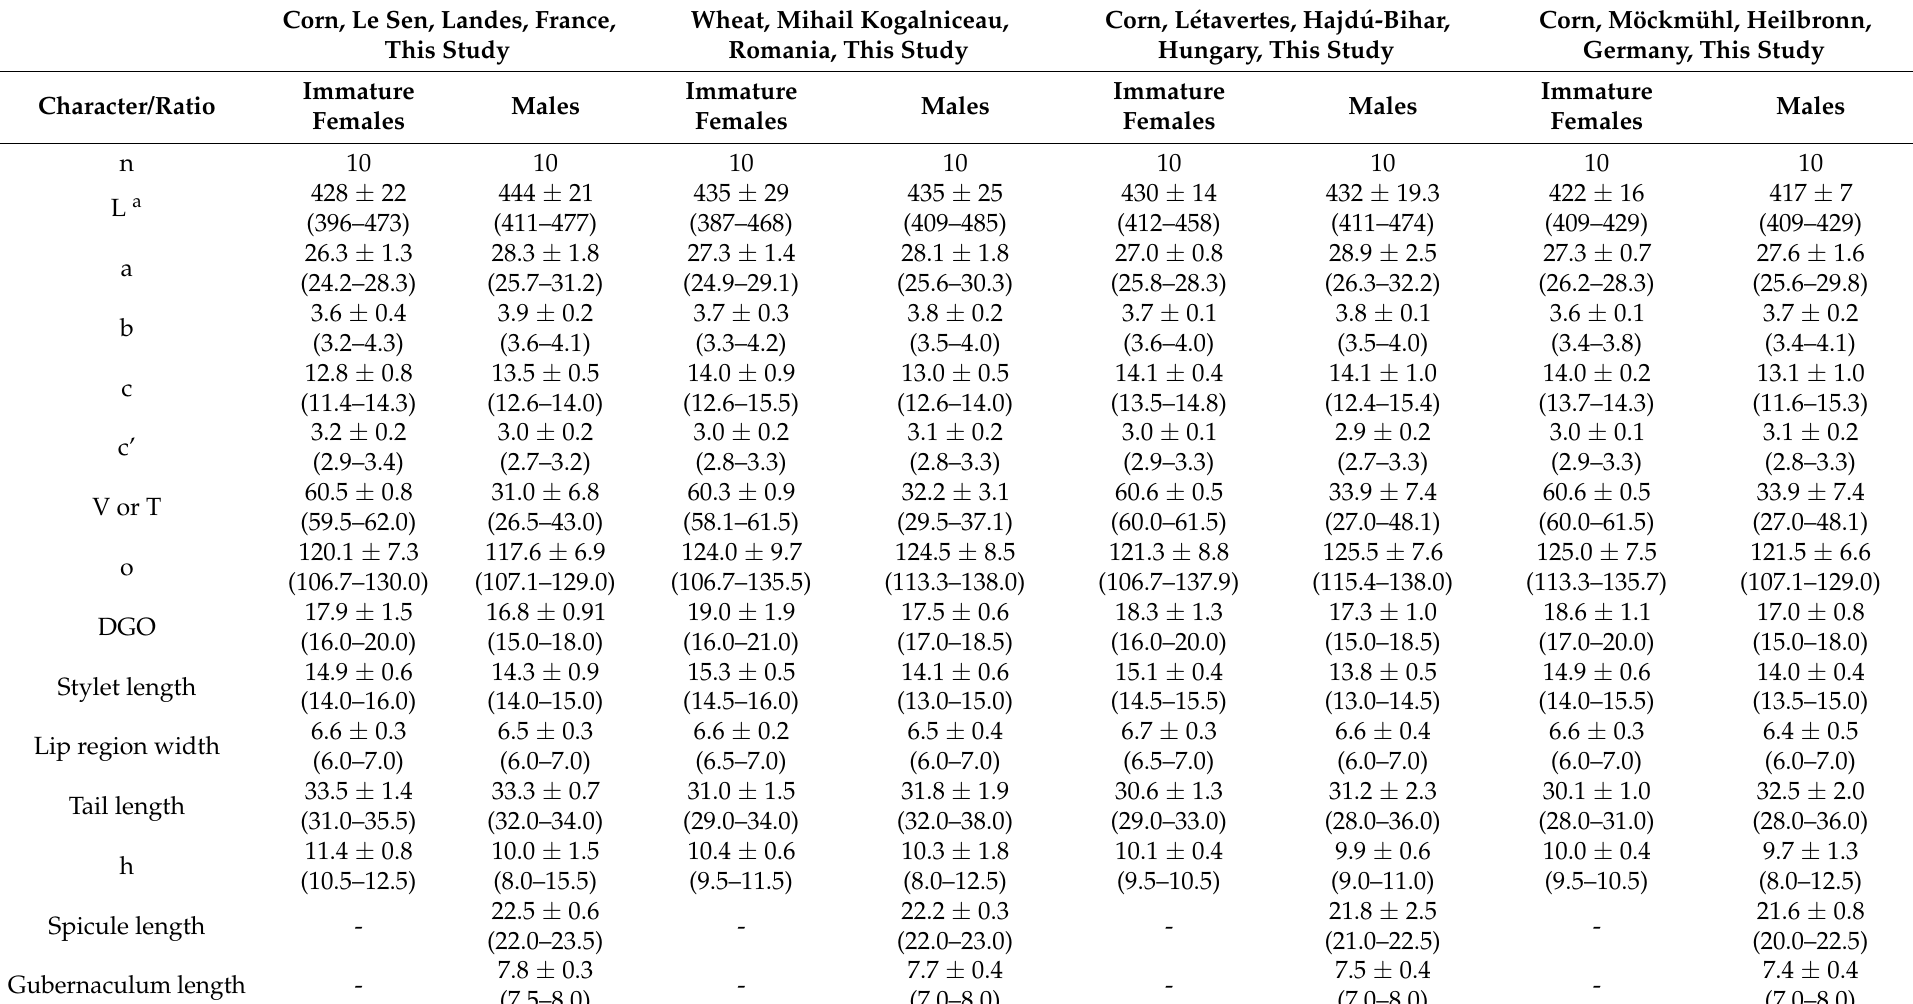
Table 8. Measurements of immature females and males of Rotylenchulus borealis (= R. macrosoma) from corn and wheat from several localities in Europe. All measurements are in micrometers and in the form mean ± SD